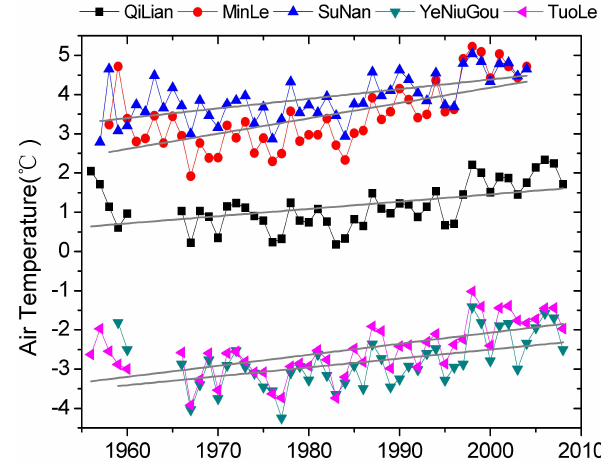
Fig. 3. Depletion curves of the snow coverage for the elevation zones in the upper basin of Heihe River during the snowmelt season in 2004.